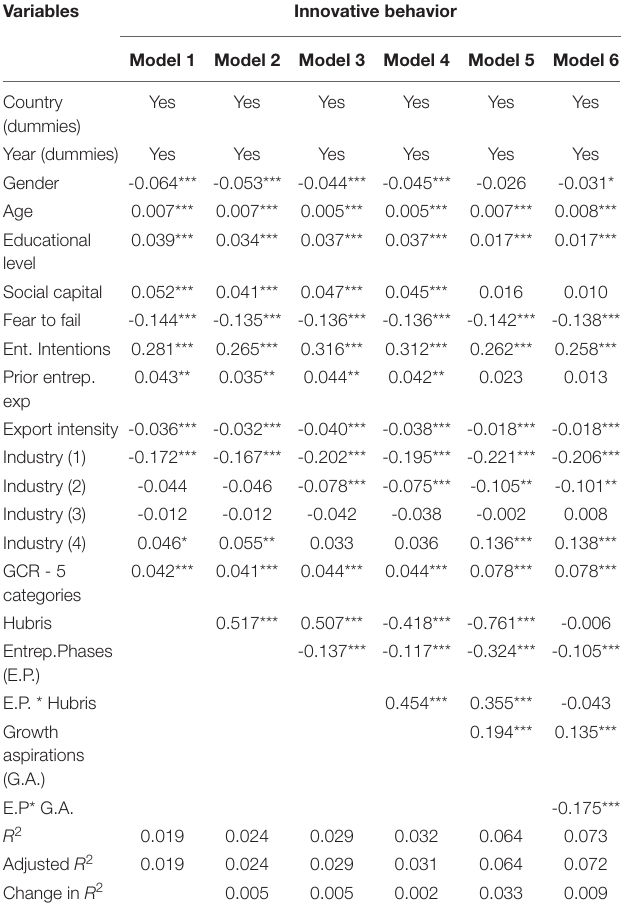
TABLE 4 | Results of the moderated mediation